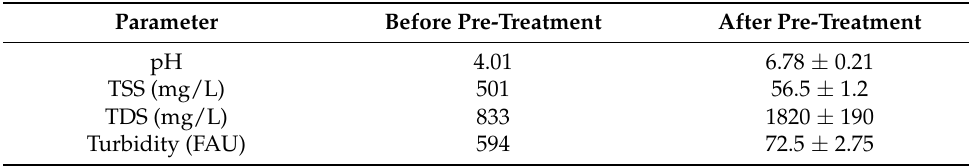
Table 4. Tofu wastewater data before and after pre-treatment.